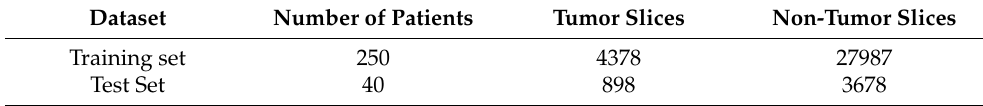
Figure 3. CT image of lungs from the dataset: LIDC in the different sagittal planes. Table 1. Overview of the Dataset used.